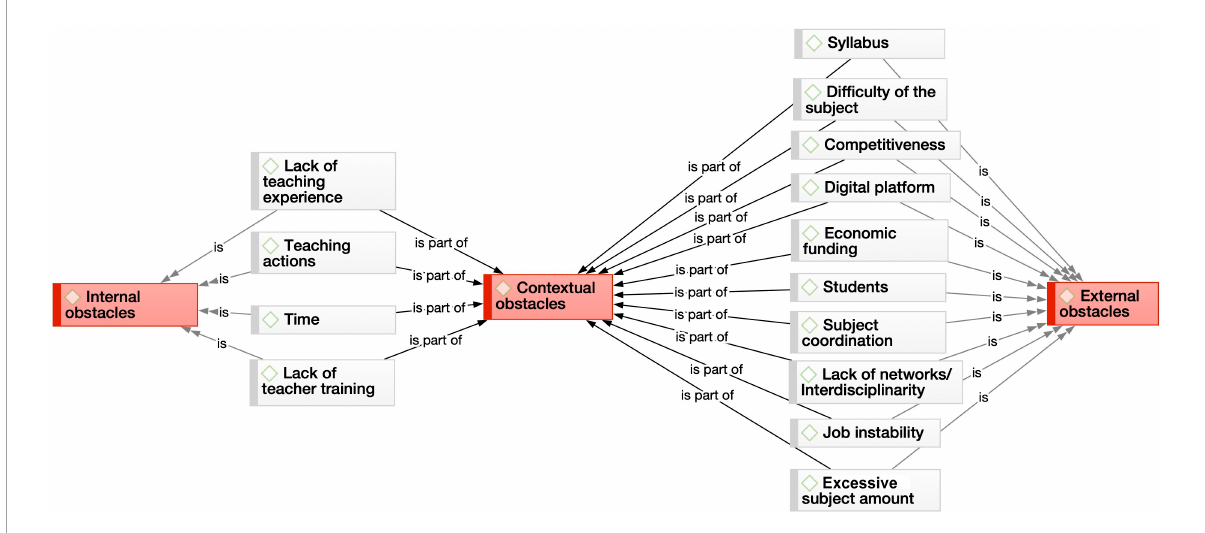
FIGURE7 Contextual